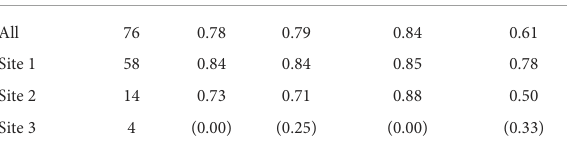
TABLE 4 Performance of our method on Test Cath per